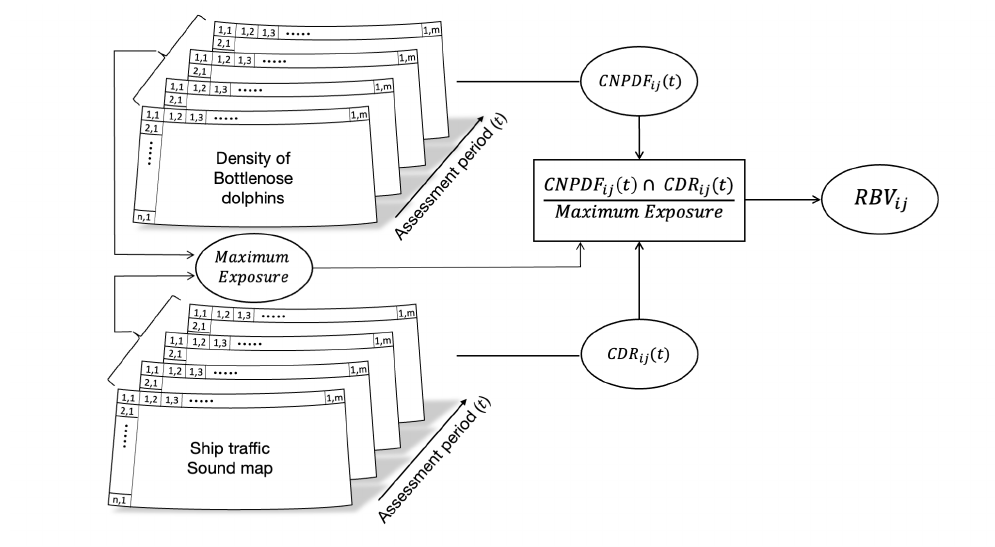
Figure 9. Diagram block that summarizes the methodology applied to obtain the risk-based